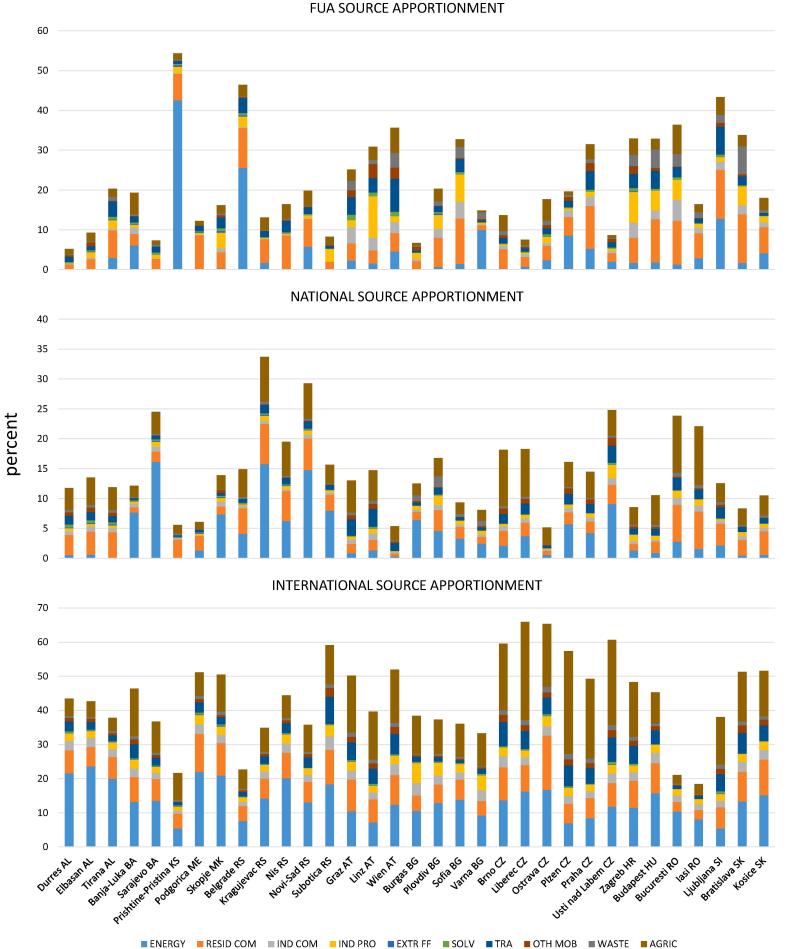
Bar plots of the impact of geographical sources on PM2.5 in the 33 studied cities split by activity sectors. ENERGY: Energy production; RESID COM: residential combustion; IND COM: industrial combustion: IND PRO: industrial processes; EXTR FF: extraction and distribution of fuels; SOLV: use of solvents; TRA: road transport; OTH MOB: other mobile machinery; WASTE: waste treatment and disposal; AGRIC: agriculture.